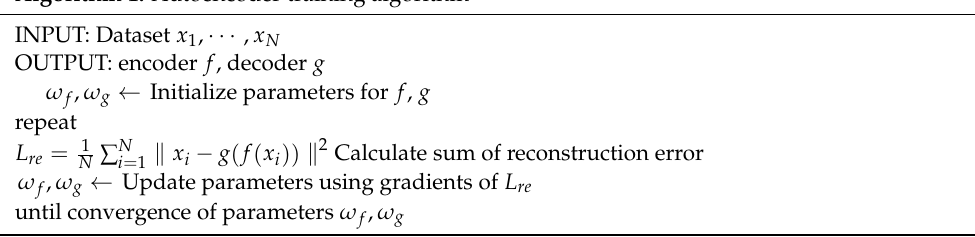
Algorithm 1: Autoencoder training algorithm